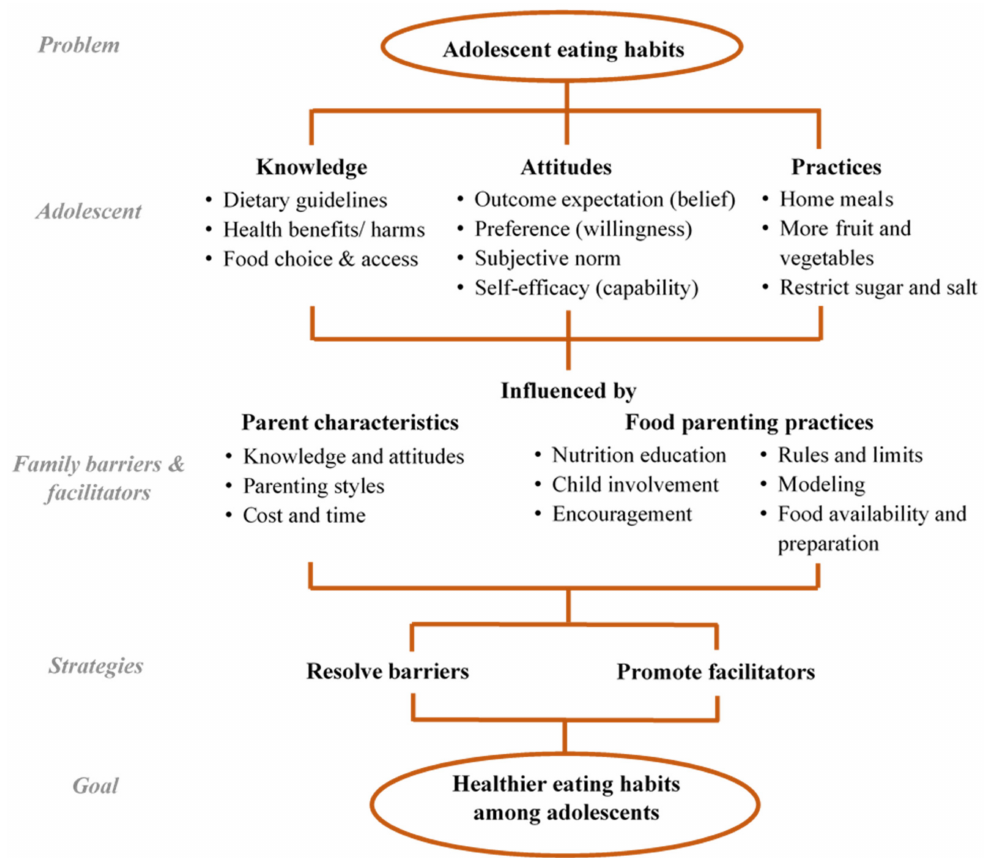
Figure 1. Theoretical Knowledge, Attitudes and Practices framework for data extraction on family